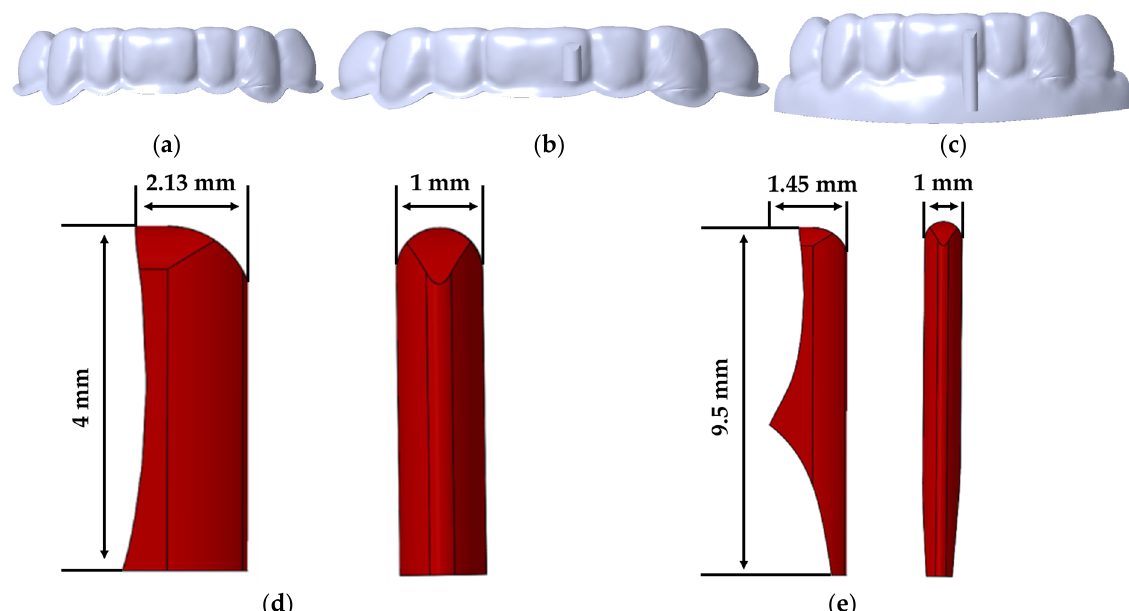
Figure 2. A 3D aligner model design. ( a ) Aligner with the NA; ( b ) aligner with the GA; ( c ) aligner with the OA; ( d ) shapes and dimensions of the general composite attachment; ( e ) shapes and dimensions of the overhanging composite attachment.